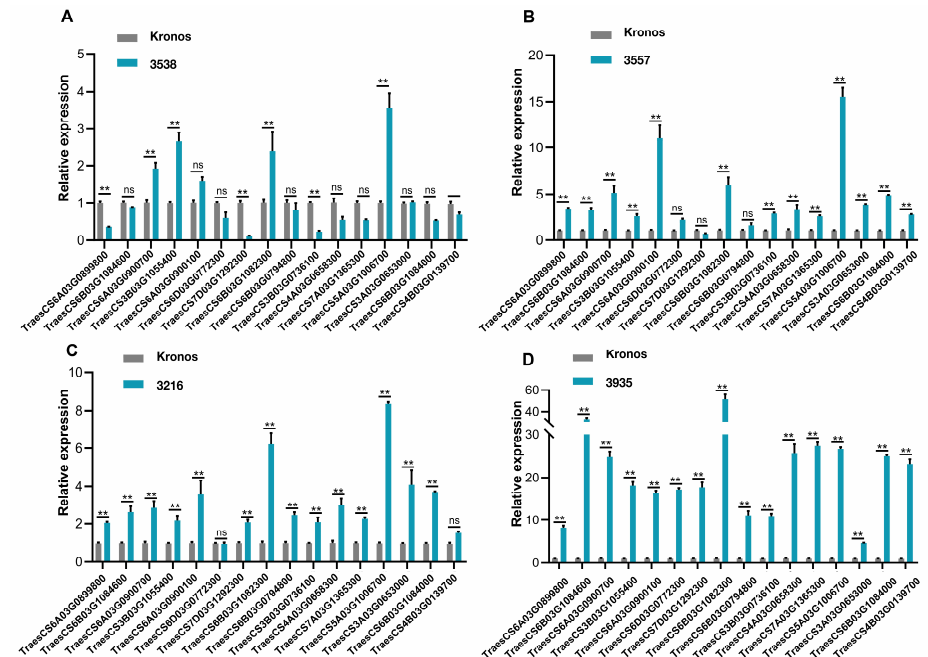
Figure 8. Expression patterns revealed by RT-qPCR treated with 15% PEG-6000. ( A ) The expression patterns of 16 highly expressed genes in mutant 3538 compared with Kronos, mutant 3557 ( B ), in mutant 3216 ( C ), and in mutant 3935 ( D ). The experiment was repeated three times, and the error bar represents the SD of the means ( n = 3). ** represents p < 0.01. ns indicates not